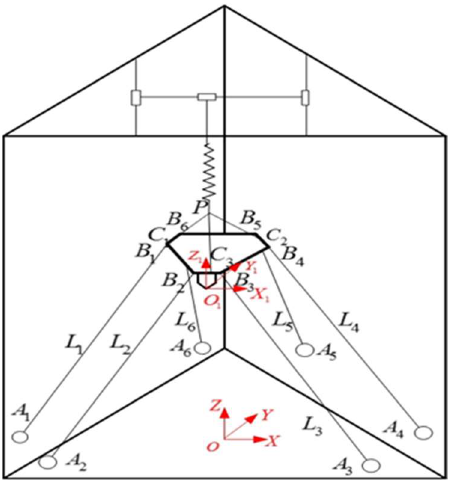
Fig ure 2. Sketch of the CDPR for 3D Printing. Figure 2. Sketch of the CDPR for 3D